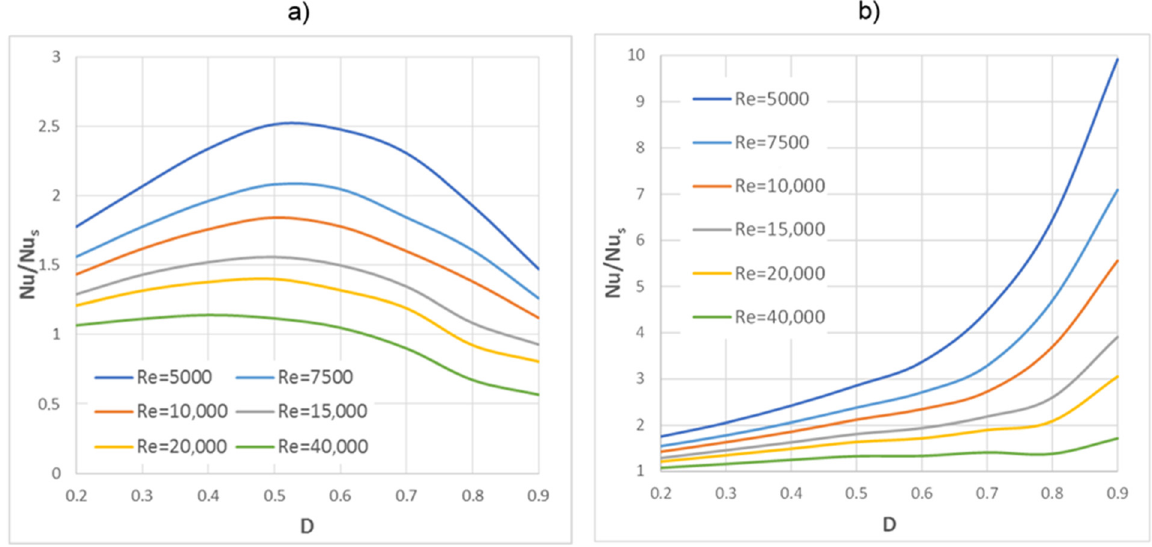
Figure 13. Nu / Nu s ( D ) ratio for several Re numbers, calculated from the average temperature: ( a ) from the whole pipe; ( b ) from the annular section.